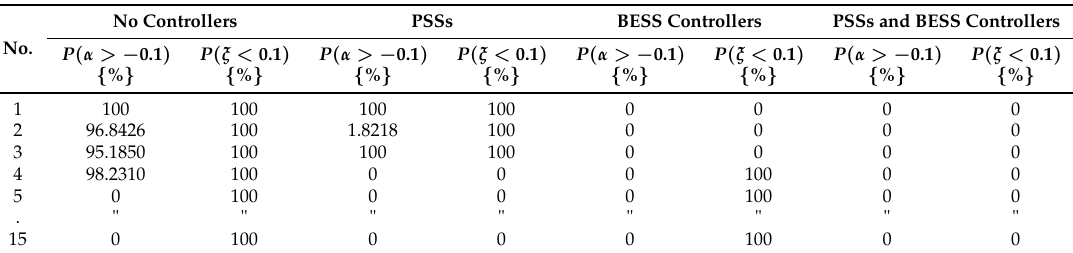
Table 11. Stability indices under different controller conditions for Scenario 3 using